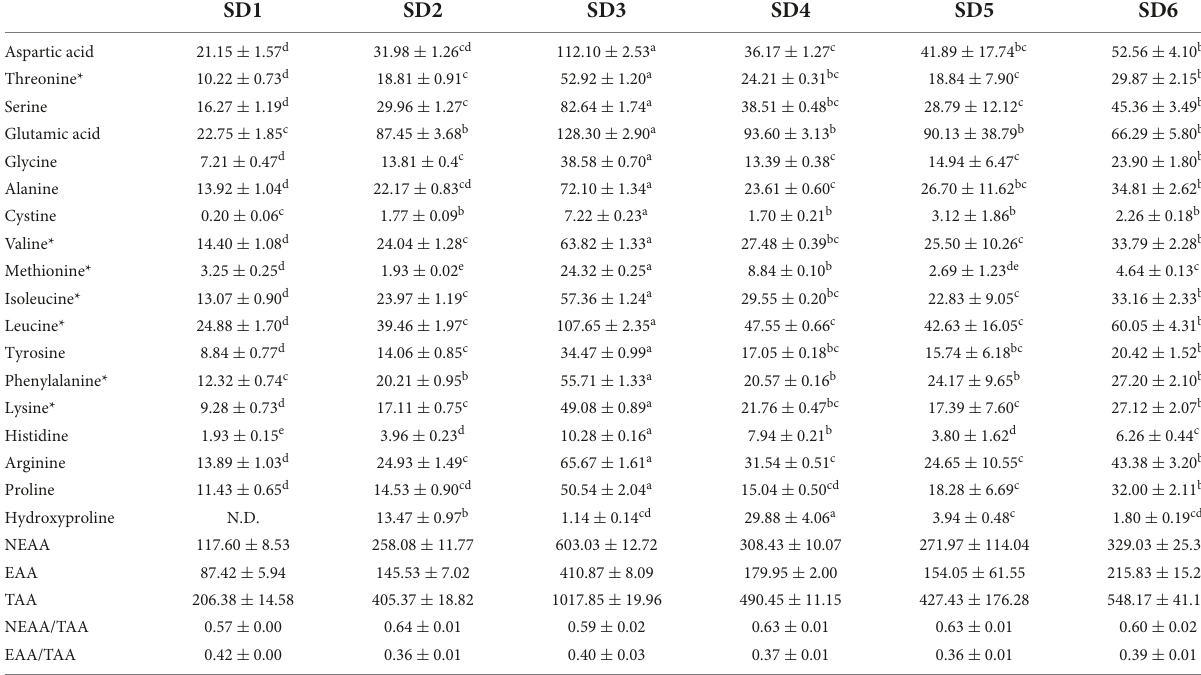
TABLE 5 Amino acid content in different sweet salad dressing (mg/100 g).